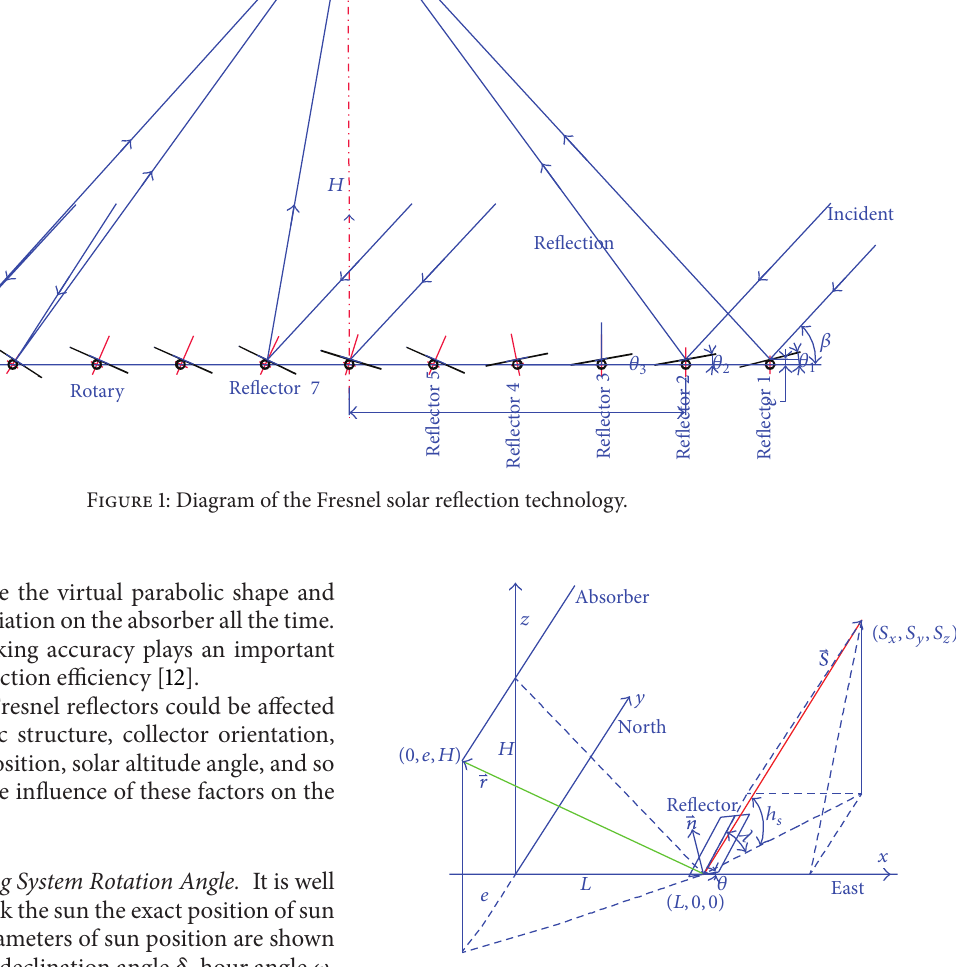
Figure 2: Diagram of ray reflection of Fresnel